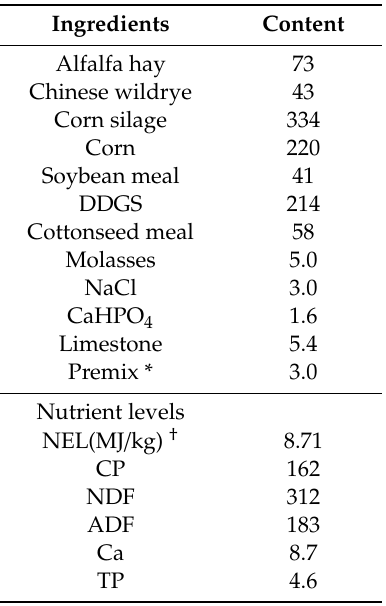
Table 1. Feed ingredients and chemical composition (g / kg DM) of the